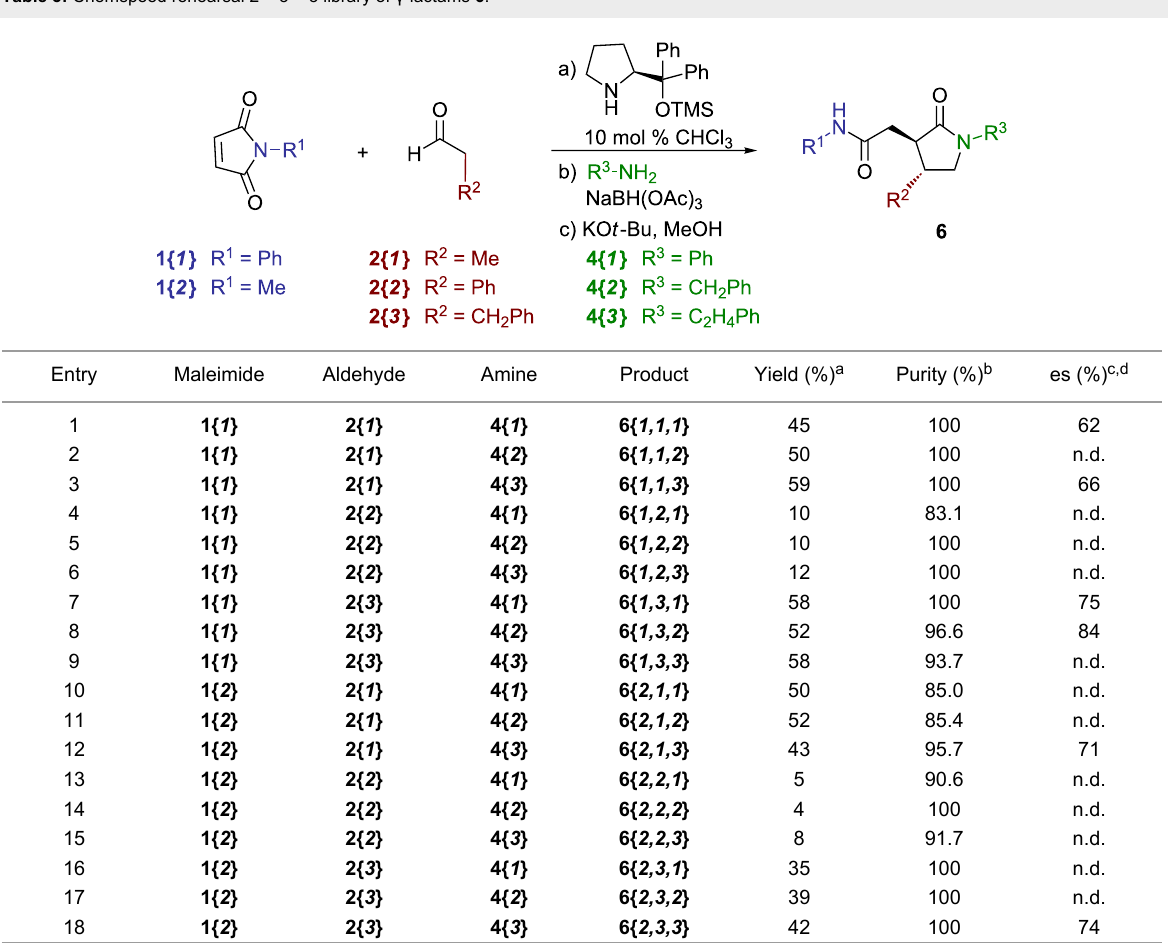
Table 3: Chemspeed rehearsal 2 × 3 × 3 library of γ -lactams 6